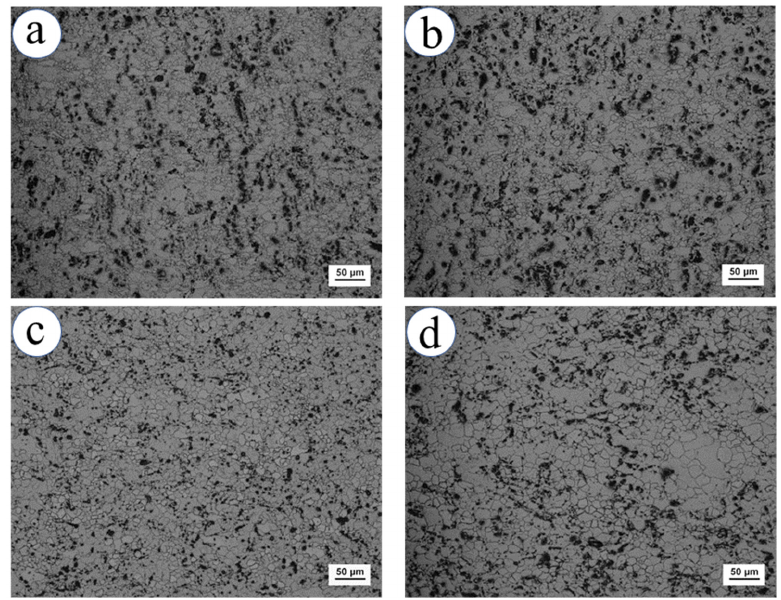
Figure 5. The ED surface microstructure of 1 β -TCP/Mg-3Zn-0.2Ca composite: ( a ) C-4 P-553 K, ( b ) C-4 P-573 K, ( c ) C-4 P-593 K, ( d ) C-4 P-613